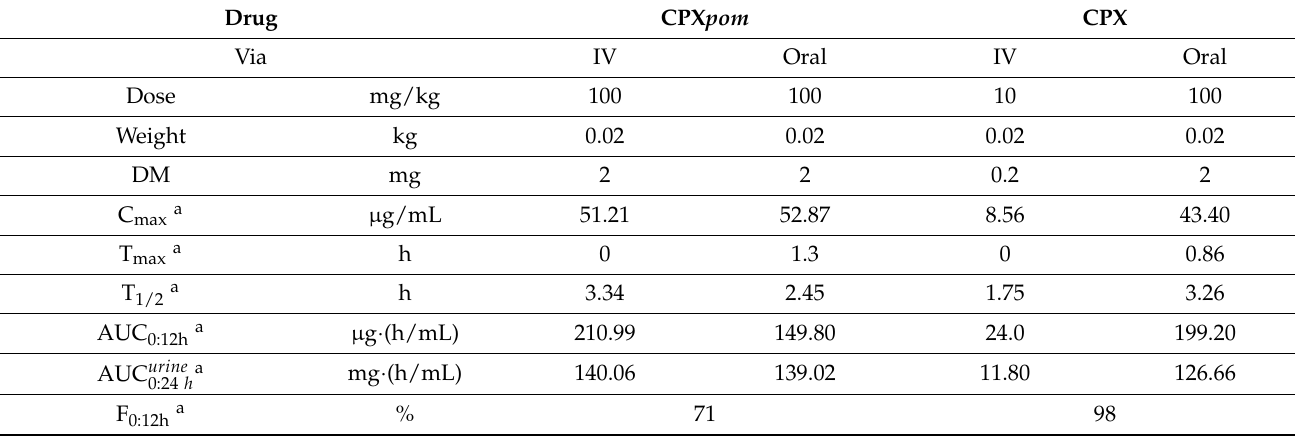
Figure 4. Serum CPX concentrations ( µ g/mL) as a function of time, as determined by NMR spectroscopy. CPX tot is the sum of CPX free and CPX glu . Mean serum CPX concentrations are shown as squares, whereas the SD values are expressed in bars. Line values correspond to the fitting curve determined for each experiment. Table 1. Serum CPX pharmacokinetic parameters in mice following single IV or oral doses of CPX pom and CPX. Non- compartmental analysis is assumed for values